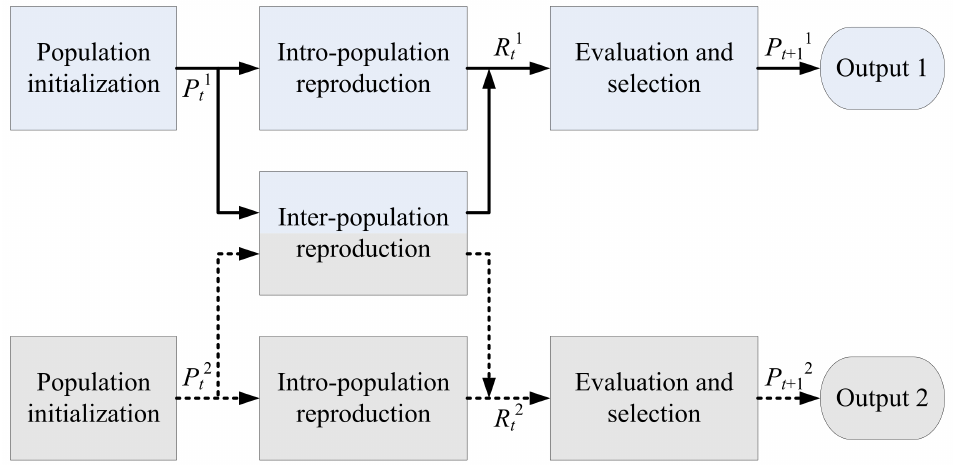
Figure 6. Multi-population evolution model for a simple case comprising two tasks